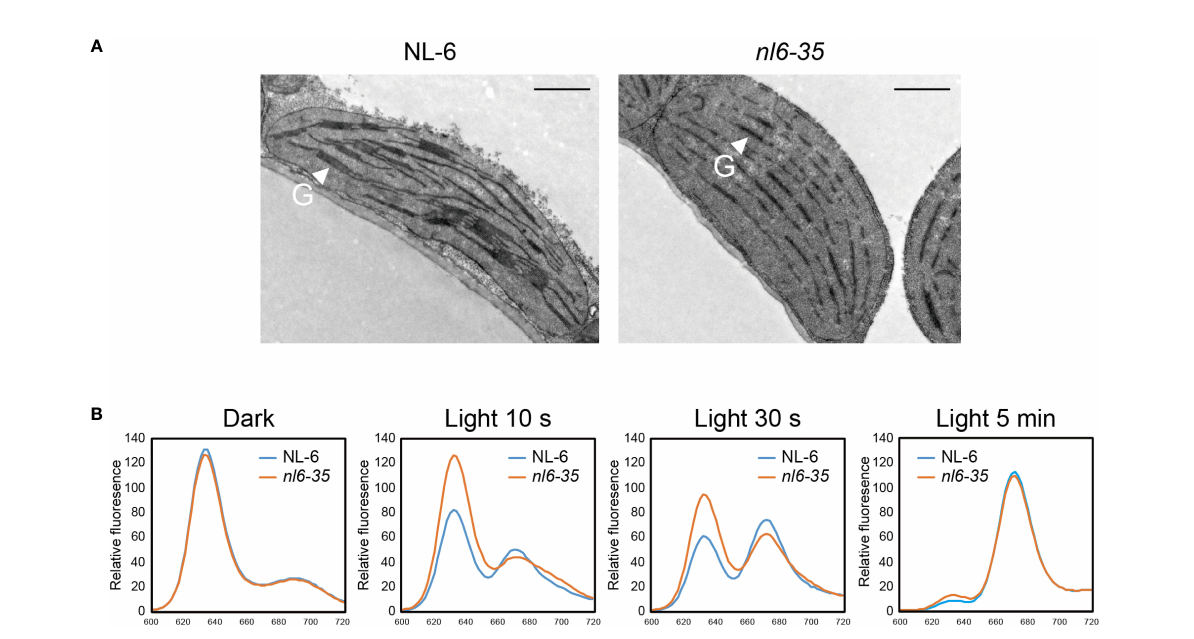
FIGURE 3 Transmission electron microscopy (TEM) analysis of plastids and measurement of Pchlide in nl6-35 mutant. (A) 10-day-old wild type (NL-6) and nl6-35 leaves grown under long-day conditions (16 h light/8 h dark) were collected for the analysis of grana in chloroplast. G, grana stacks. Scale bar, 1.0 m m. (B) Analysis of the conversion of Pchlide to Chlide upon illumination. Pigments were extracted from fi ve-day-old etiolated seedlings in the dark or after being exposure to light for 10 s, 30 s, and 5 min. Total Pchlide was calculated from the fl uorescence emission at 634 nm, while Chlide was calculated from the fl uorescence emission at 672